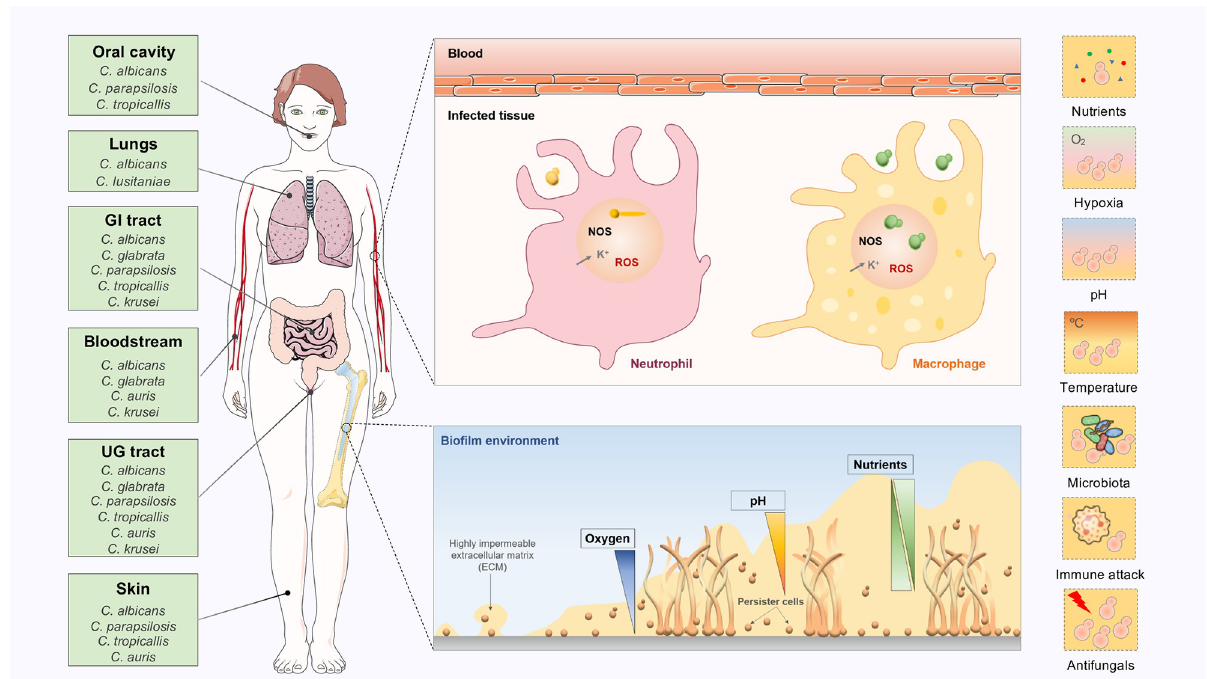
Fig 1. Candida biogeography and the different host-imposed constraints during human colonization. The most frequently isolated Candida species are listed according to their principal habitat in the human body (oral cavity, lungs, gastrointestinal tract, bloodstream, urogenital tract, and skin). The different host-imposed constraints are highlighted for several microenvironments where Candida thrives in the human body, including inside phagocytic cells or biofilms. Key references: C . albicans [2,3], C . glabrata [3], C . parapsilosis [2], C . tropicalis [2], C . lusitaniae [13], and C . krusei [6]. ECM, extracellular matrix; NOS, nitric oxide species; ROS, reactive oxygen species; UG, urogenital.